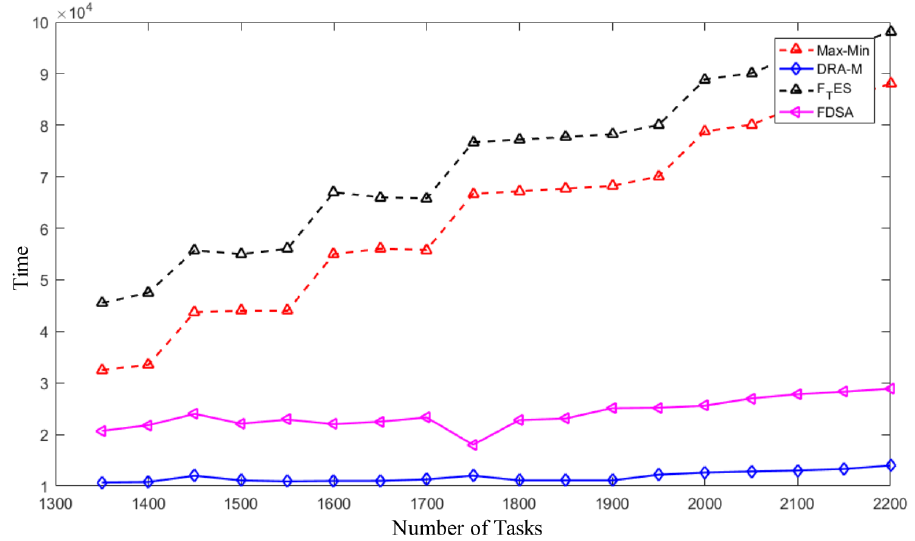
Figure 10. Time comparison diagram of four algorithms.